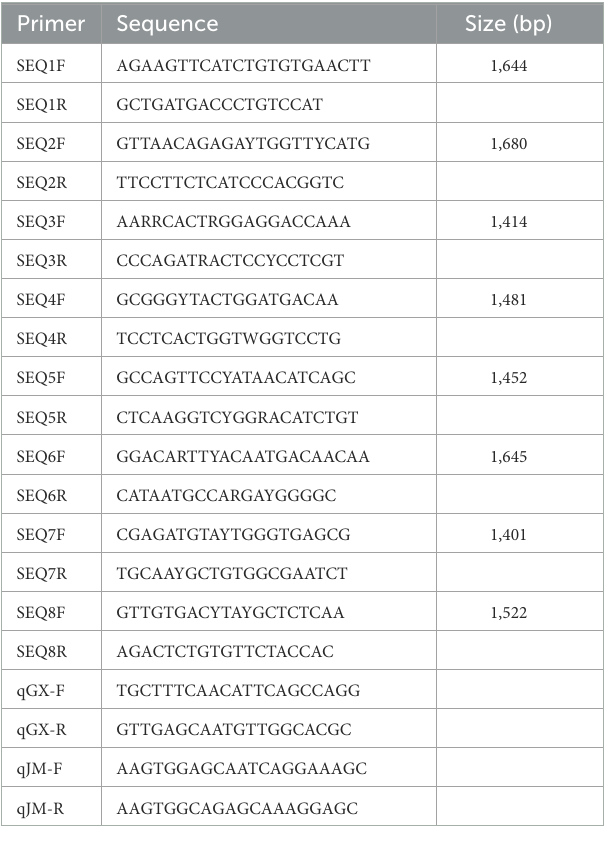
TABLE 1 Primers used in this